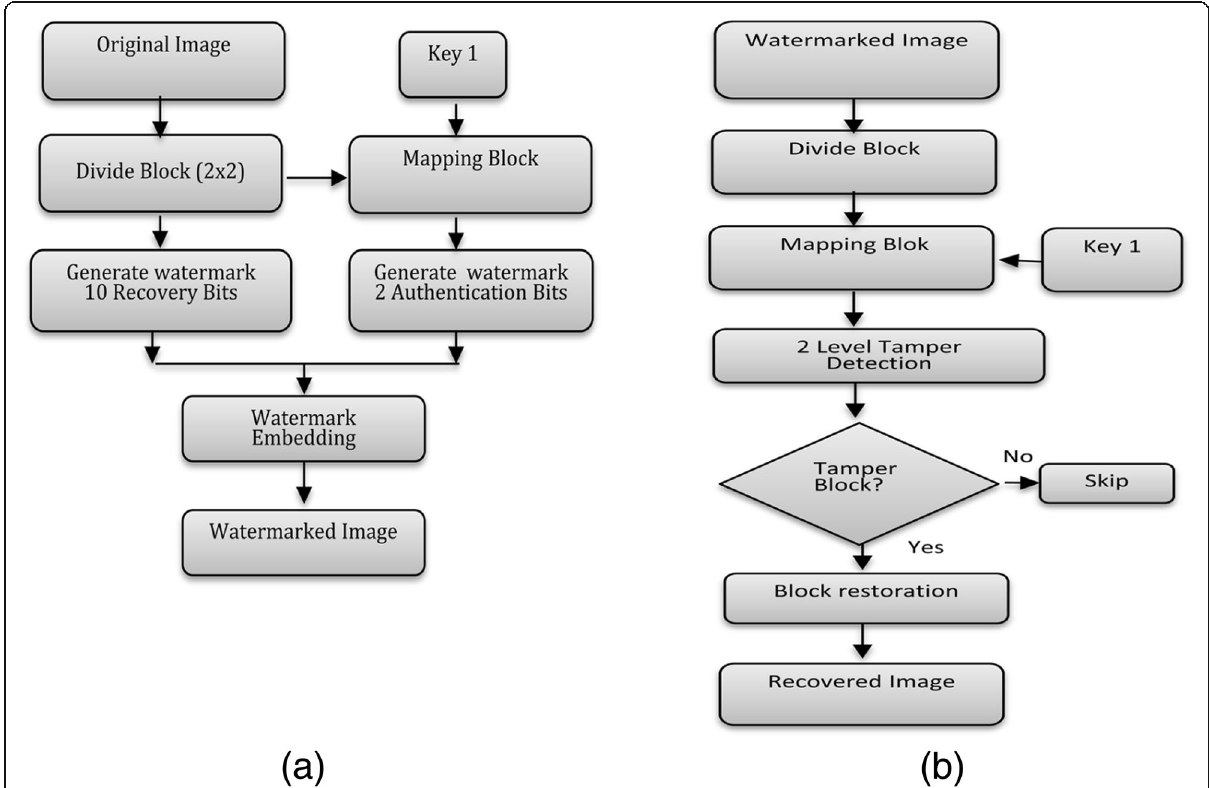
Fig. 15 Block diagram of ( a ) watermark embedding and ( b ) extraction process for Singh et al. ’ s method [1]